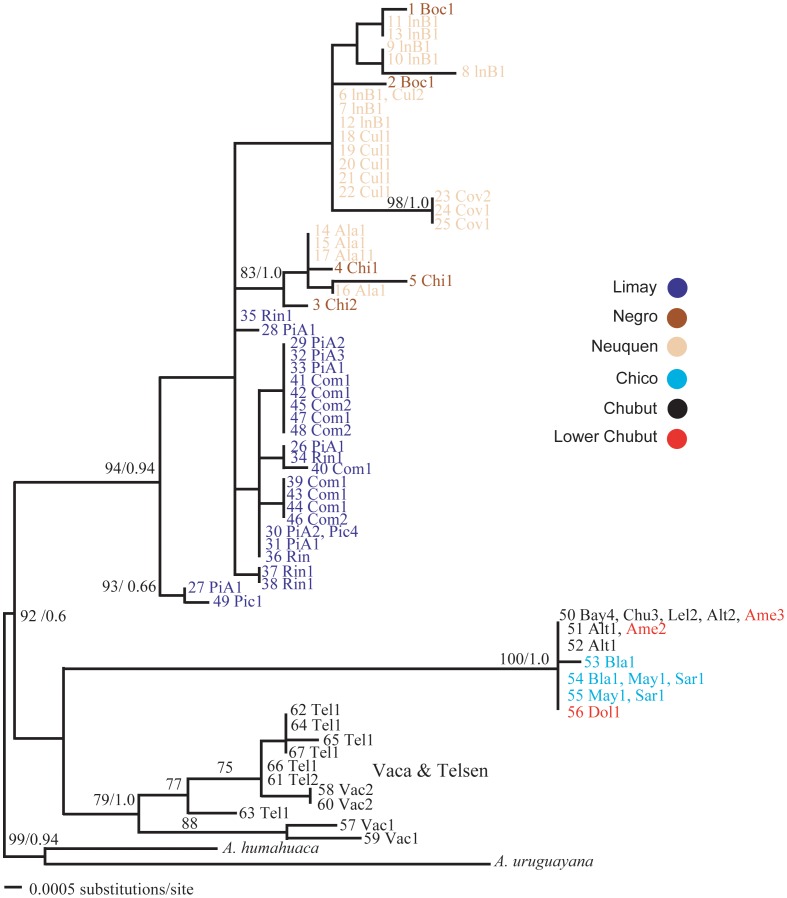
ML trees based on concatenated nDNA haplotypes of Aegla neuquensis.Numbers above branches are ML bootstrap supports (pre/) and Bayesian posterior probabilities (post/). Locality (see Table 1) and number of individuals are shown after that haplotype. Color codes indicate the six major rivers.